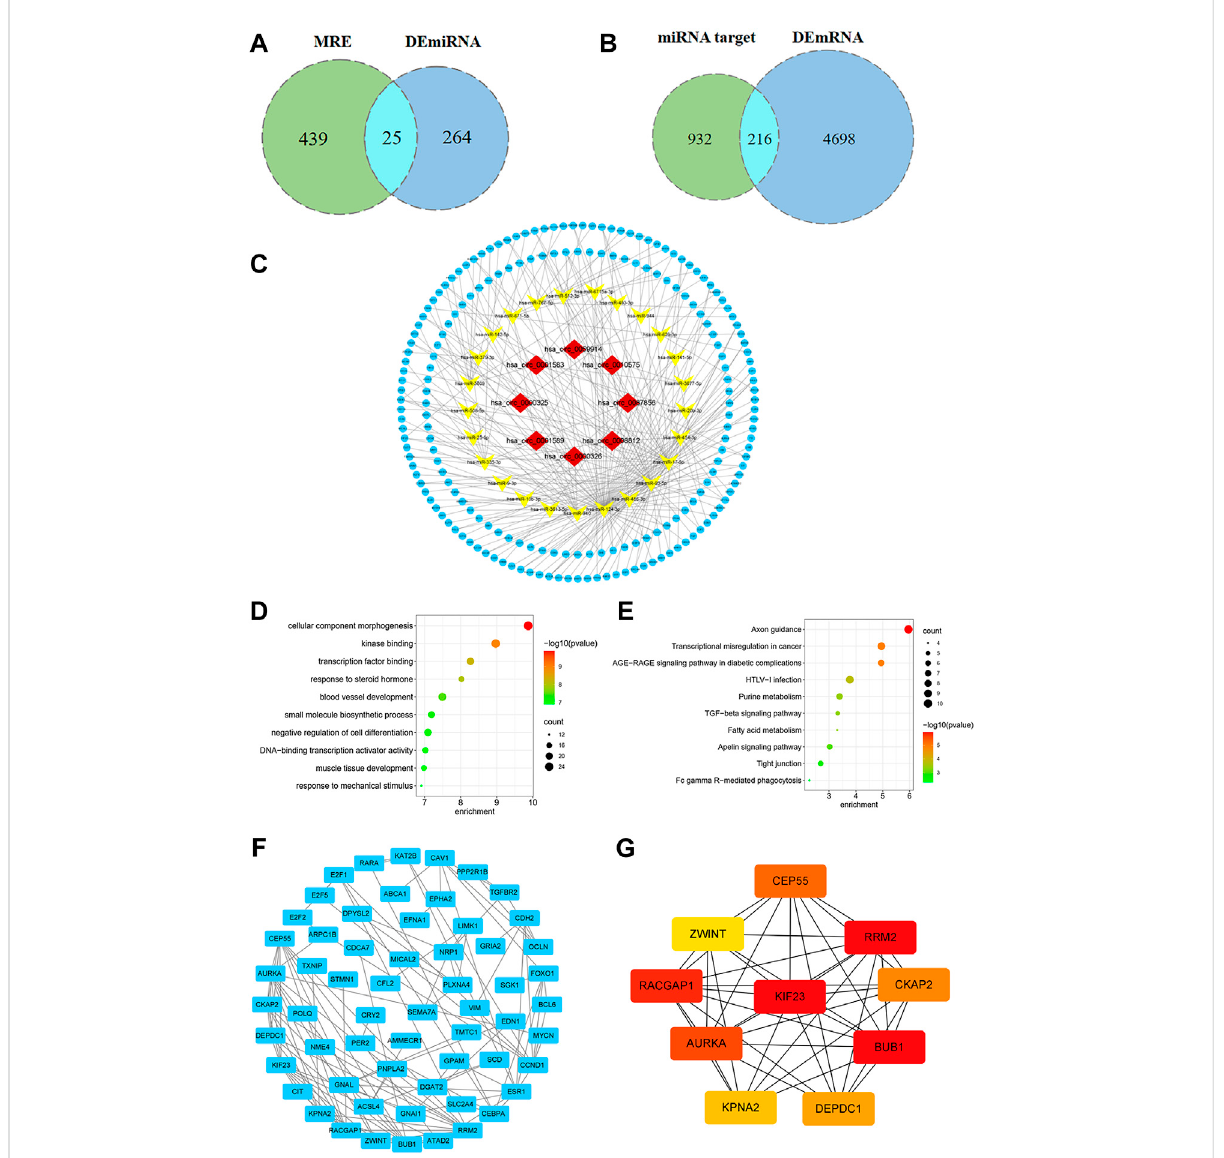
FIGURE 3 Construction of ceRNA network and identi fi cation of hub genes. (A) Venn diagram of overlapping miRNAs between circRNA-targeted miRNAs and DEmiRNAs. (B) Venn diagram of overlapping mRNAs between miRNA-targeted mRNAs and DEmRNAs. (C) The circRNA-miRNA-mRNA regulatory network in breast cancer. (D) GO analysis of candidate mRNAs. (E) KEGG pathway analysis of candidate mRNAs. (F) PPI network of 216 genes, consisting of 60 nodes and 117 edges. (G) PPI network of the top 10 hub